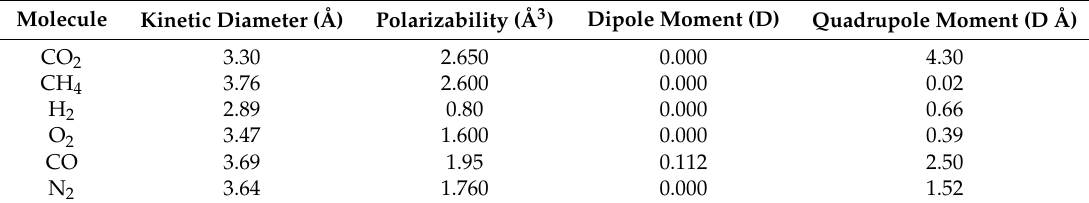
Table 3. Features of the main gas molecules used for gas separation. Adapted from [5].